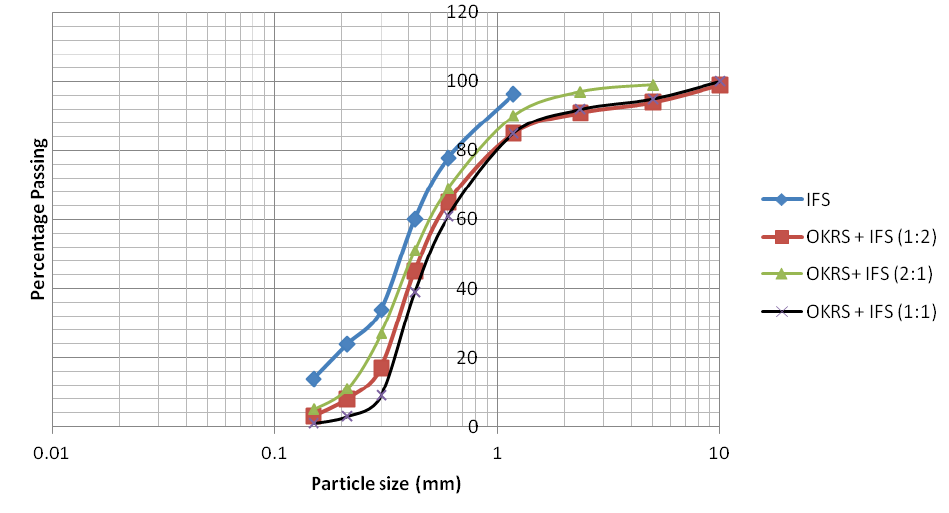
Figure 4. Grading curves for IFS and its various combinations with